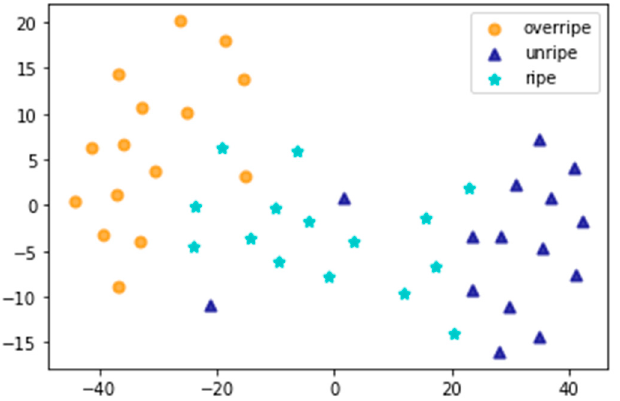
Figure 8. The t-SNE visualization of the flue-cured NTL leaves from three different maturity grades. They were clustered into three groups according their maturity degrees. This indicated that the maturity grades were closely related to their own metabolites.